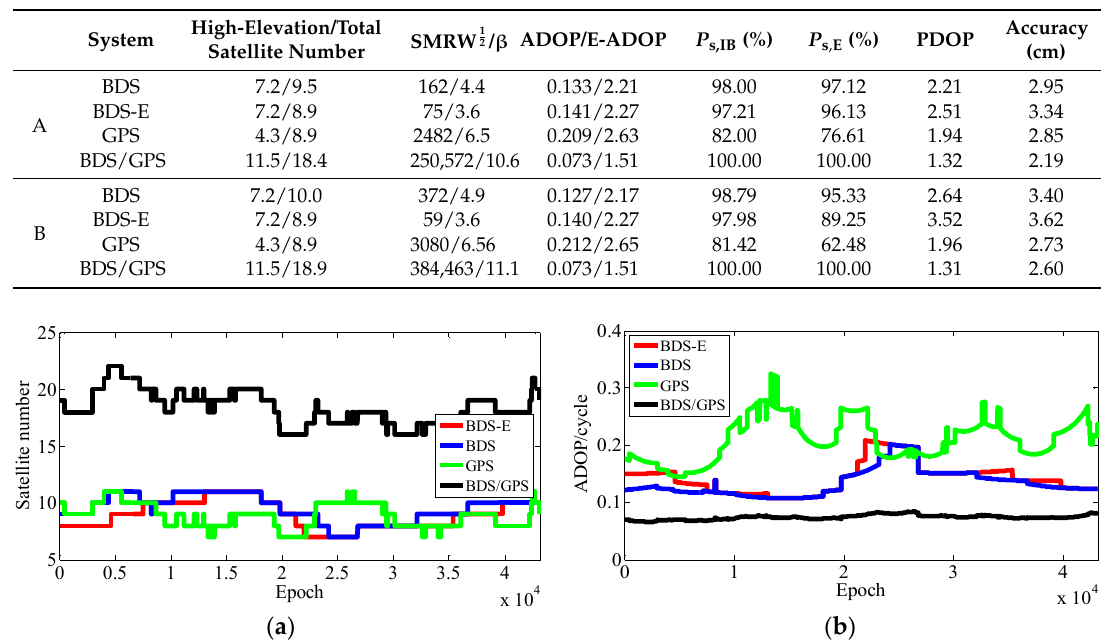
Table 5. Results of BDS, BDS-E, GPS and BDS/GPS for 15 km baseline.